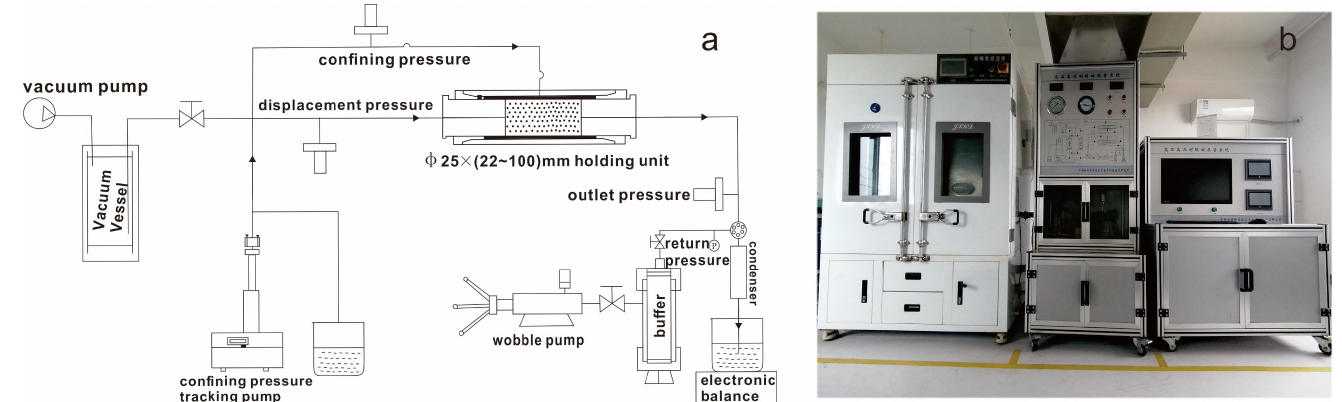
Figure 2. Experimental setting for water–rock displacement. ( a ) diagram for displacement instrument; ( b ) photo demonstration of replacement equipment.